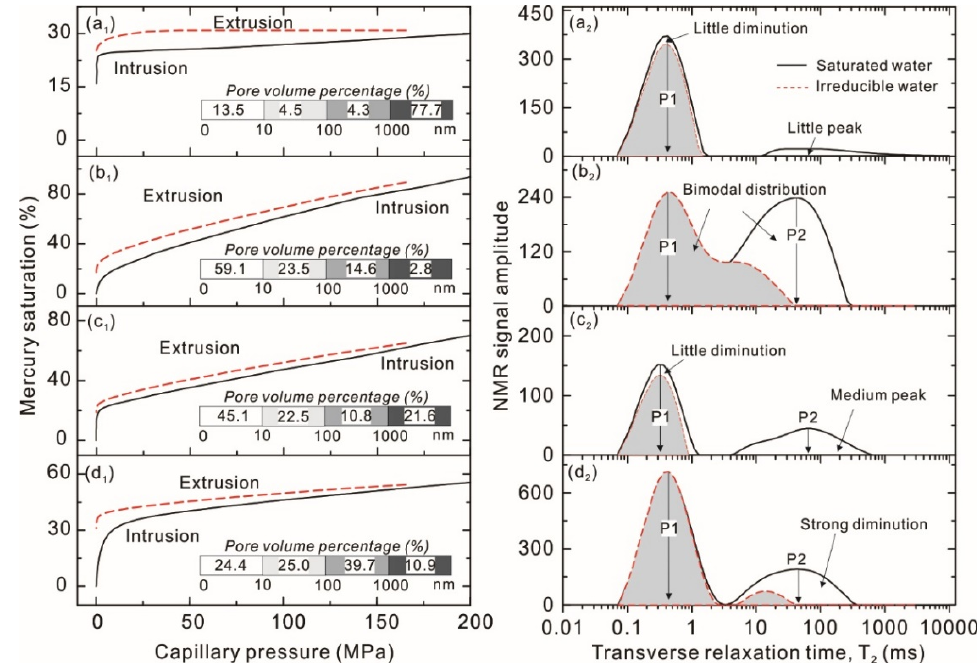
Figure 9. Coal facies and pore and fissure structures of the selected samples from the southern Junggar Coalfield. ( a 1 , a 2 ) average values of coal facies (1) samples; ( b 1 , b 2 ) average values of coal facies (2) samples; ( c 1 , c 2 ) average values of coal facies (3) samples; ( d 1 , d 2 ) average values of coal facies (4) samples.